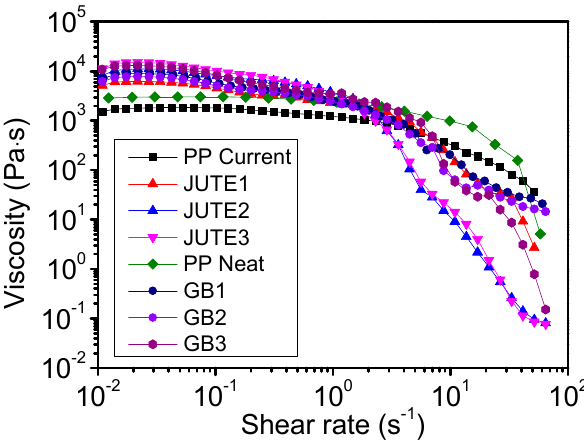
Figure 3. Effect of shear rate on shear viscosity at a temperature of 200 °C for different materials.